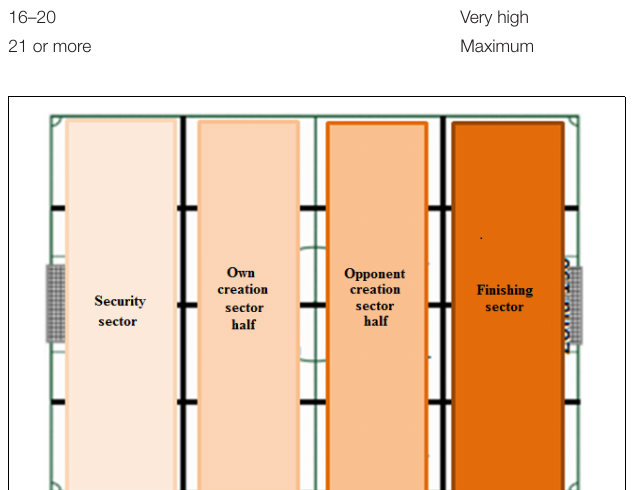
FIGURE 1 | Division into sectors to assess depth. Source: Garganta (1997).